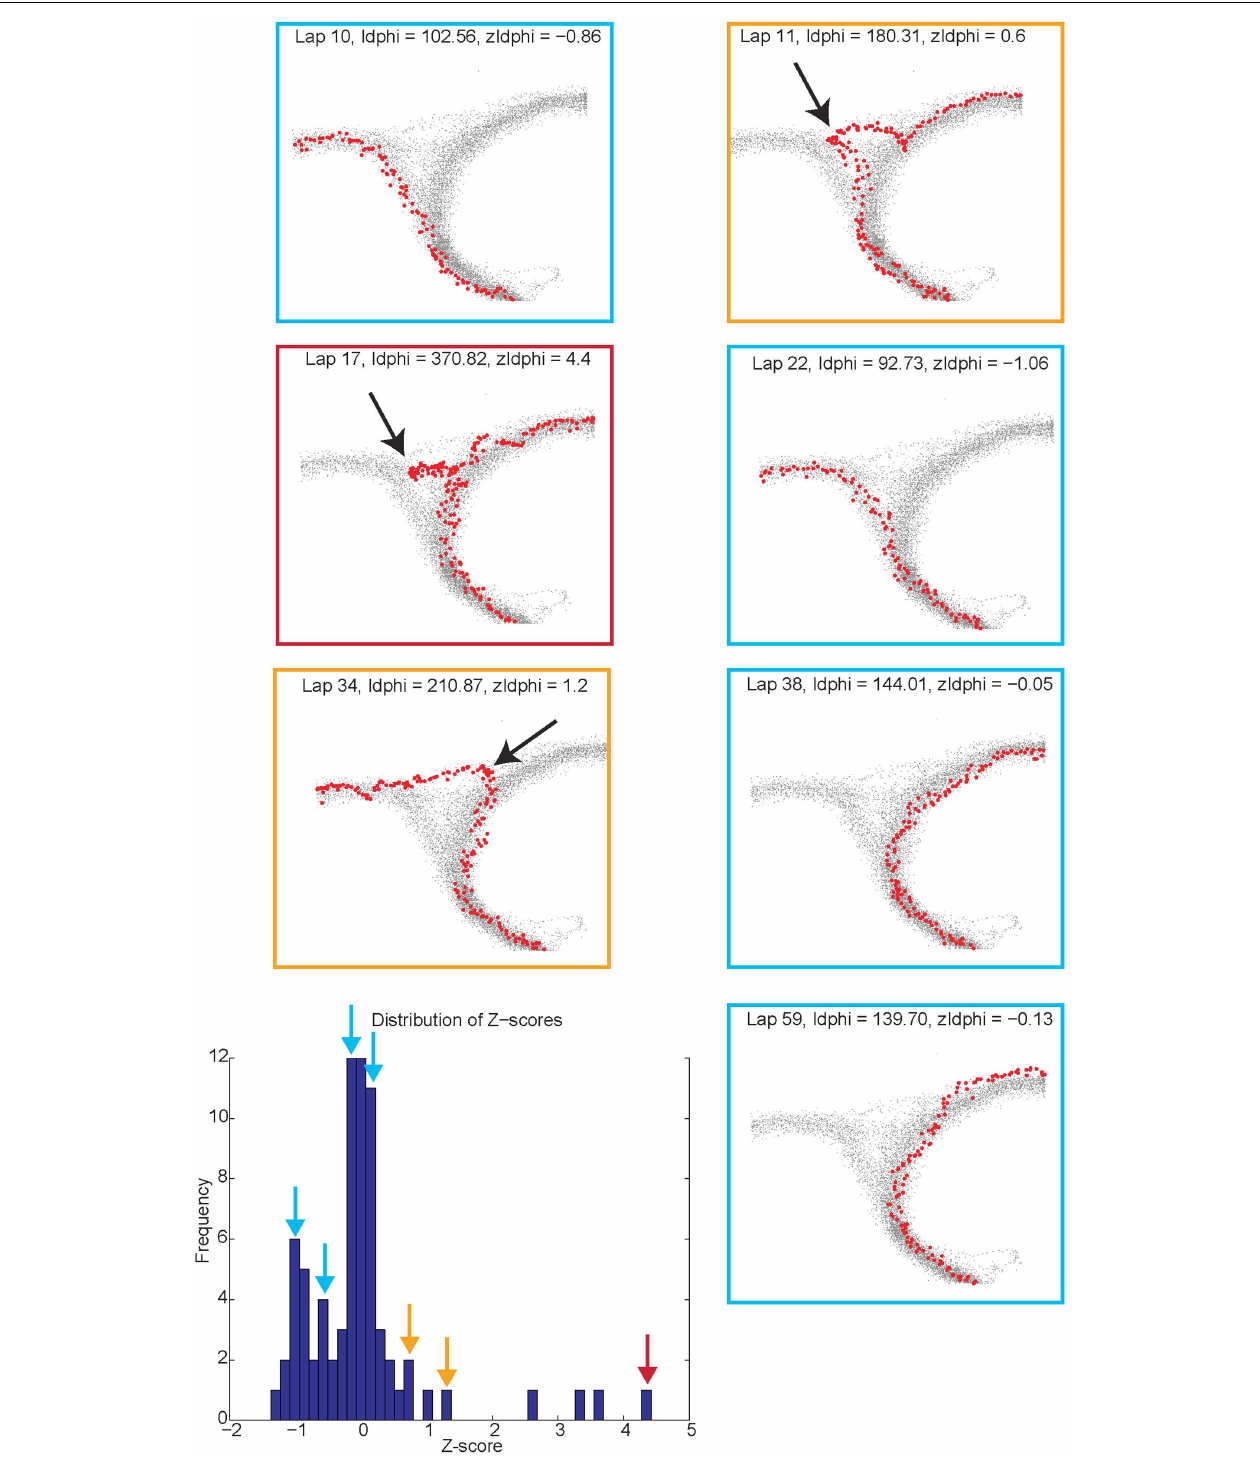
demonstrated little behavior indicative ofVTE (Blue squares). High zIdPhi passes were less common however they demonstrated large, head swings from one direction to the other (yellow and red boxes/arrows on the histogram on bottom left, black arrows on individual behavioral traces from camera